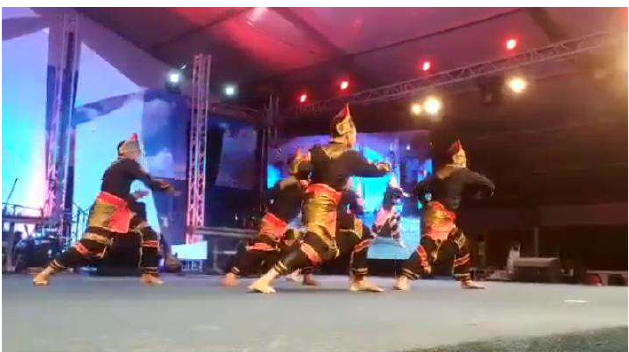
Figure 4. Male Group Participants from SMPN 2 BukitTinggi, received the 1st Place in the Province and proceed to the